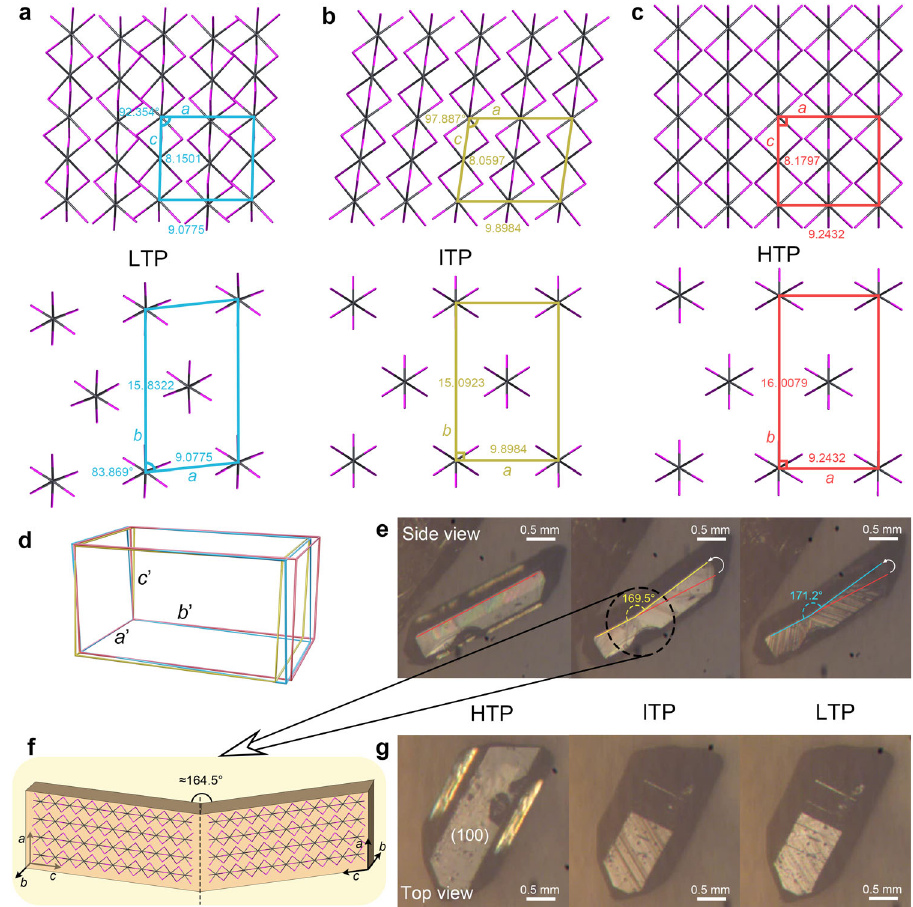
Fig.5|Microscopicandmacroscopicevolutionforsinglecrystalsshearing.a – c Cell shearing evolution of the martensitic phase transitions. Organic cations are omittedforclarity. d Comparisonofthe celllatticesintheLTP(cyan),ITP(yellow), andHTP (red).Theaxesarenormalized accordingtotheITP. e Sideviewand g top